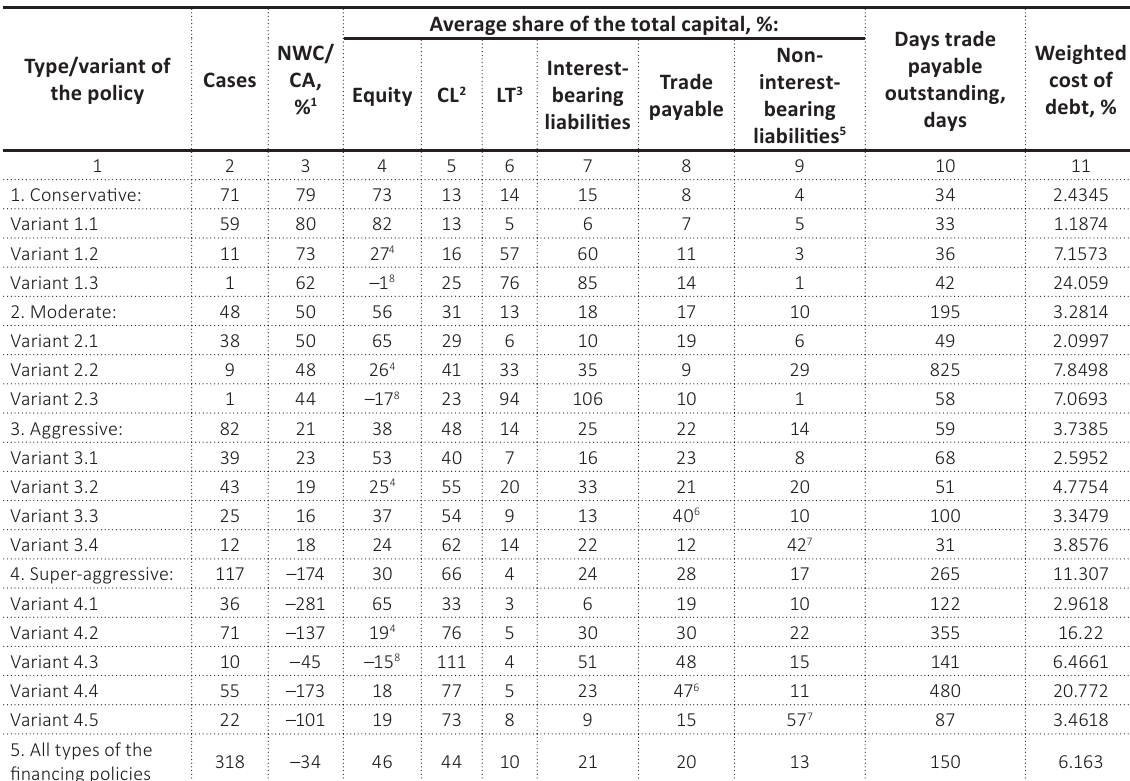
Source: Calculated by the